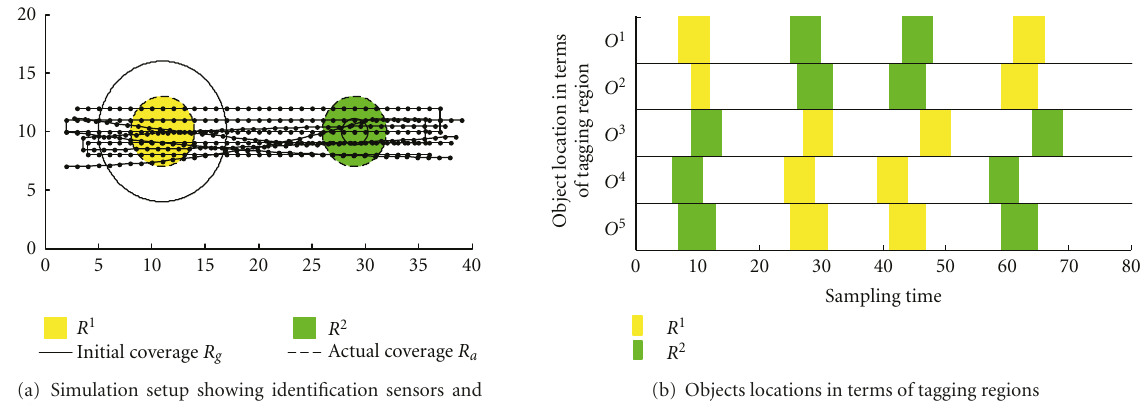
Figure 10: Illustration of simulation setup for coverage adjustment and objects locations in terms of tagging regions.